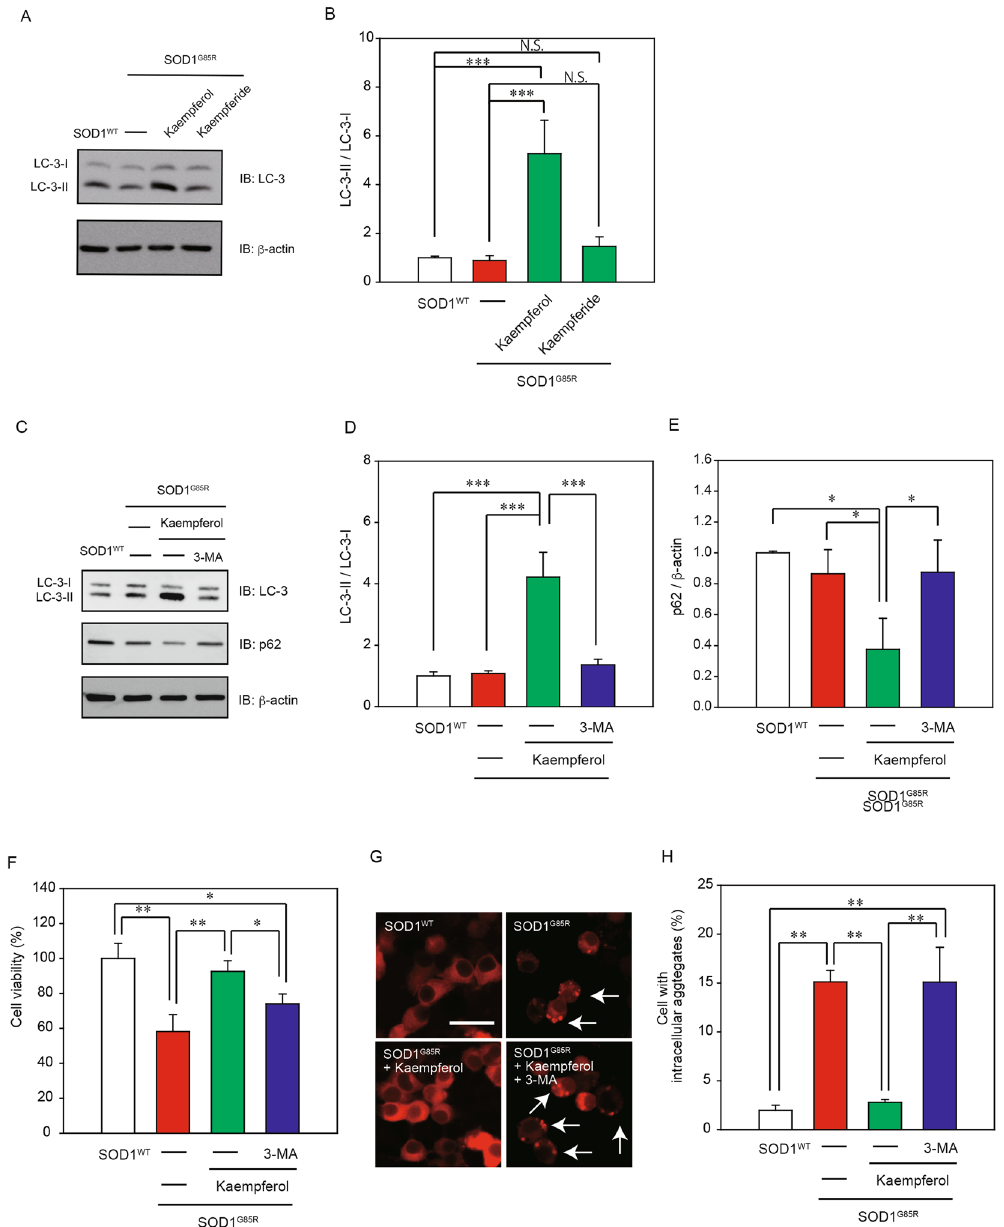
Figure 5. Kaempferol, but not kaempferide, reduced the intracellular aggregates via the activation of autophagy. ( A ) Induction of LC-3-II by kaempferol, but not kaempferide. N2a cells were transfected with SOD1 G85R , and then incubated with 3 µ M kaempferol or 15 µ M kaempferide for 24 h. The lysates were analyzed by immunoblotting with anti-LC-3 and anti- β -actin antibodies. ( B ) Relative levels of LC-3-II/LC- 3-I normalized by the expression of β -actin were quantified, based on the band density of SOD1 WT . ( C – E ) Immunoblotting analysis of autophagy. N2a cells expressing SOD1 G85R were treated with kaempferol for 24 h with and without 3-MA. The lysates were analyzed by immunoblotting with antibodies for LC-3, p62 and β -actin. Relative levels of LC-3-II/LC-3-I and p62 normalized by the expression of β -actin were quantified, based on the band density of SOD1 WT . ( F ) Representative fluorescent microscopy images of N2a cells expressing mCherry-SOD1 G85R incubated for 24 h with 3 µ M kaempferol with and without 3-MA. ( G ) Quantified data of intracellular SOD1 aggregates are expressed as mean ± S.E.M from three independent experiments. In each experiment, at least 200 cells were counted. ( H ) N2a cells expressing SOD1 G85R was incubated for 24 h with 3 µ M kaempferol with and without 3-MA. Cell viability was determined. Data is expressed as mean ± S.E.M from three independent experiments. * p < 0.05; ** p < 0.01. *** p <